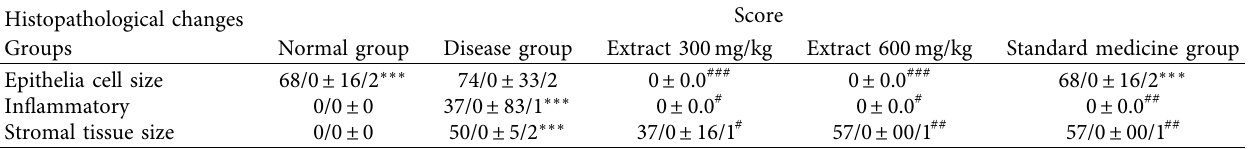
Table 3: Histopathological characteristic aspect.